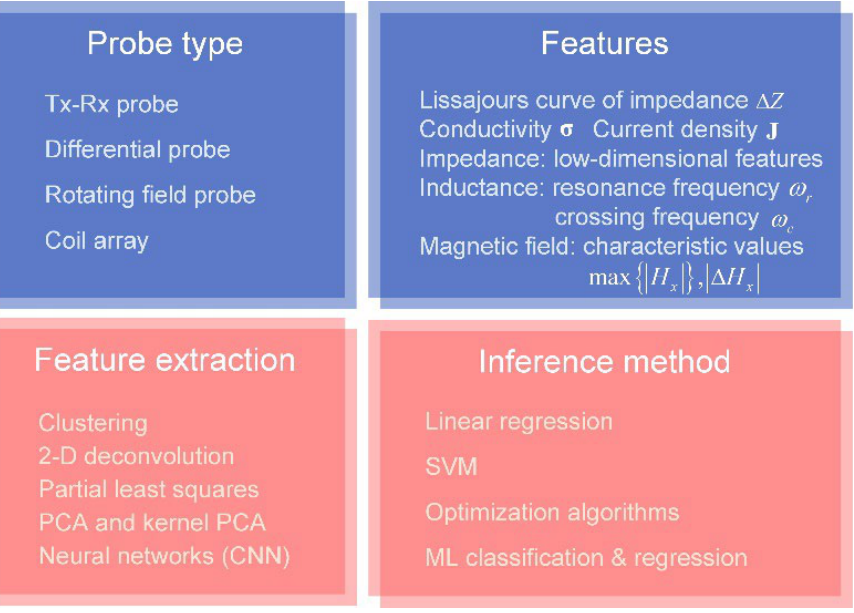
Figure 17. Key factors estimating the defect information.